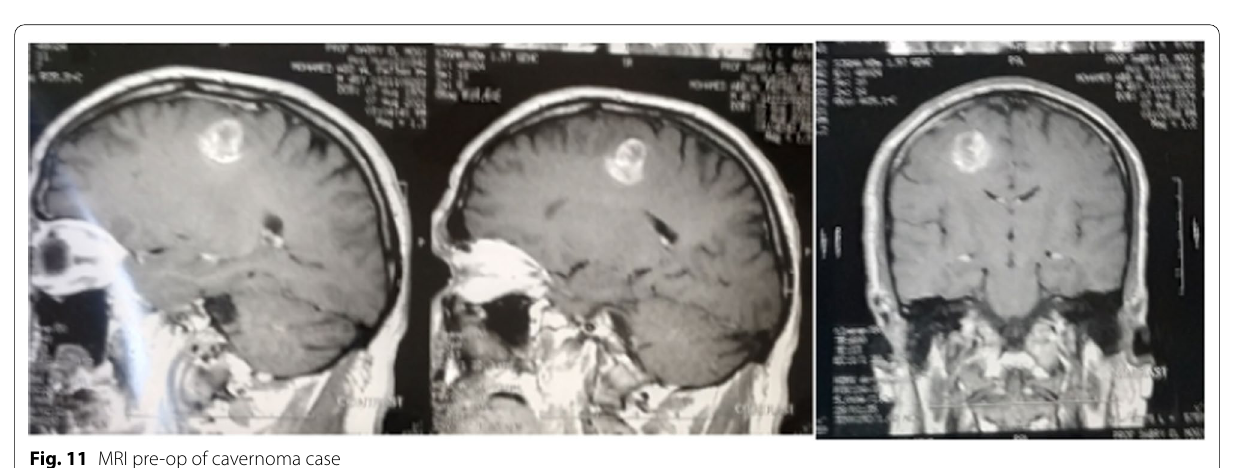
Fig. 11 MRI pre‑op of cavernoma case